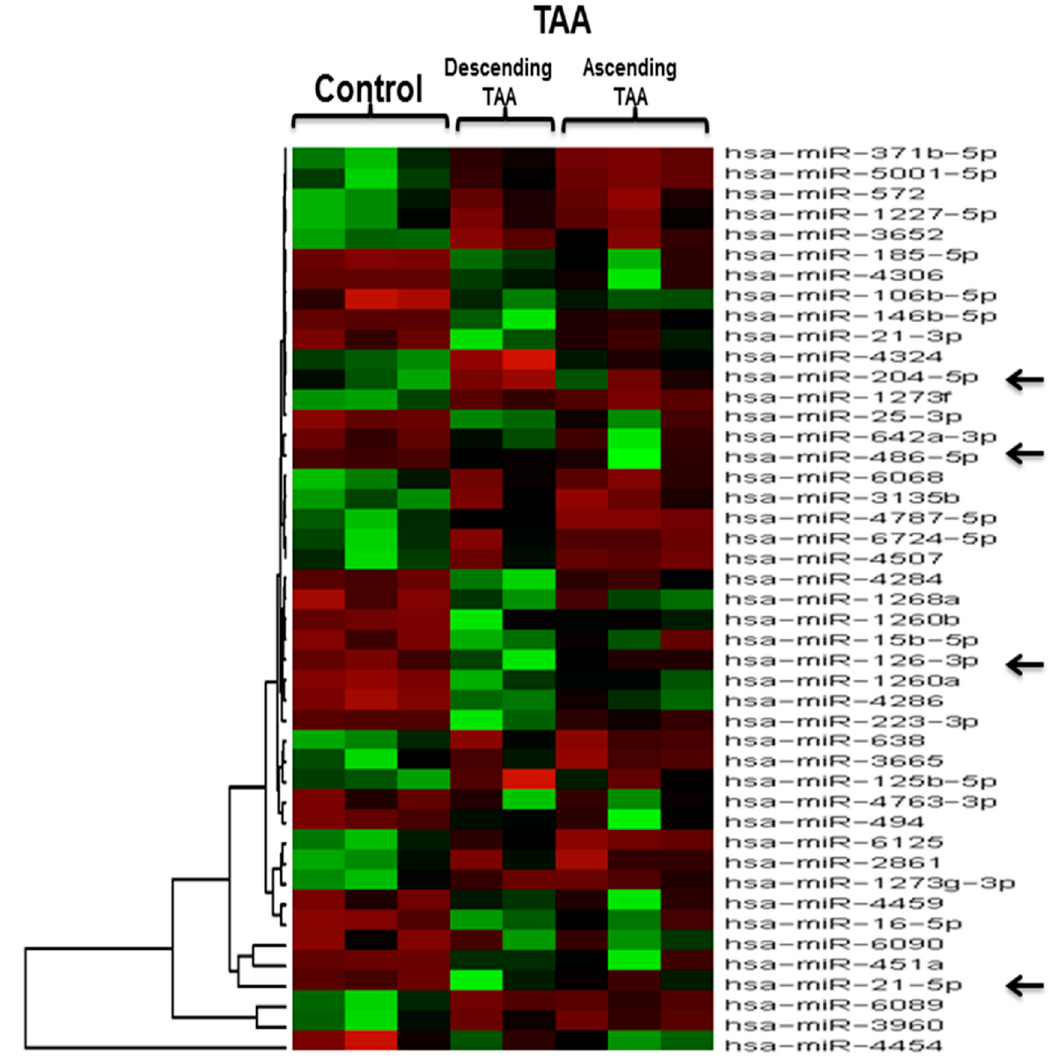
Figure 4. Heat map (Human miRNA microarray) depicting 45 differentially expressed miRNAs in TAA. Differentially expressed miRNAs ( p < 0.05 and absolute value (fold change) > 1.5) in TAA specimens as compared with non-aneurysmal control aorta is shown. Arrows indicate the miRNAs whose expression was similar in qRT-PCR analysis. TAA ( n = 5) and normal ( n = 3).